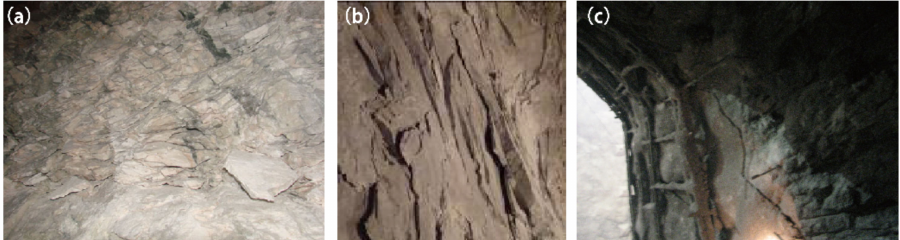
Figure 1. Splitting failure of hydropower stations. ( a ) Jinping I Hydropower Station; ( b ) Jinping II Hydropower Station; ( c ) Pubugou Hydropower